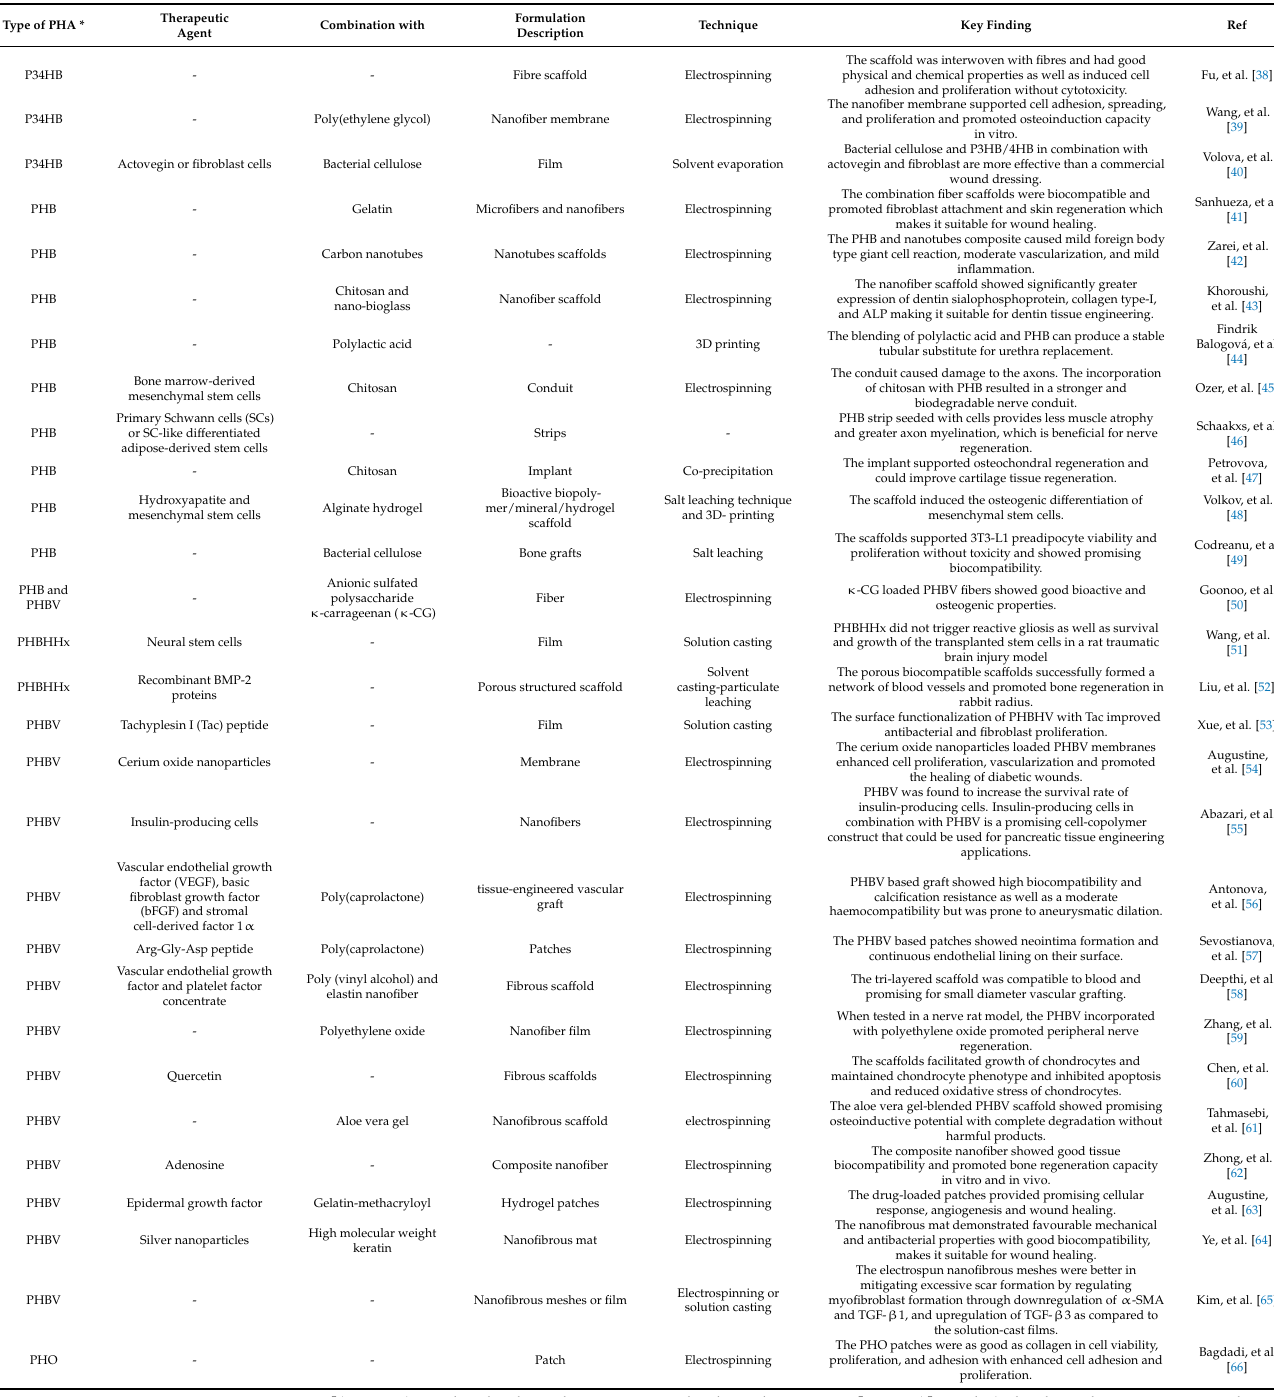
Table 1. Application of different types of PHA in tissue engineering (published between years 2017 and